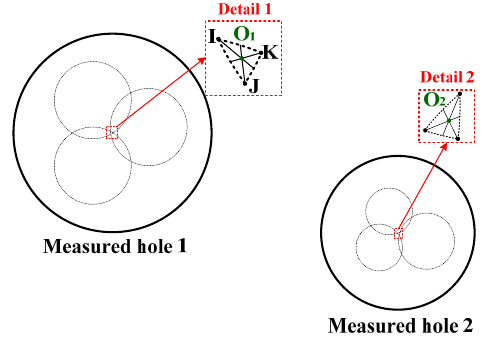
Figure 8. The actual measurement of the connecting rod.